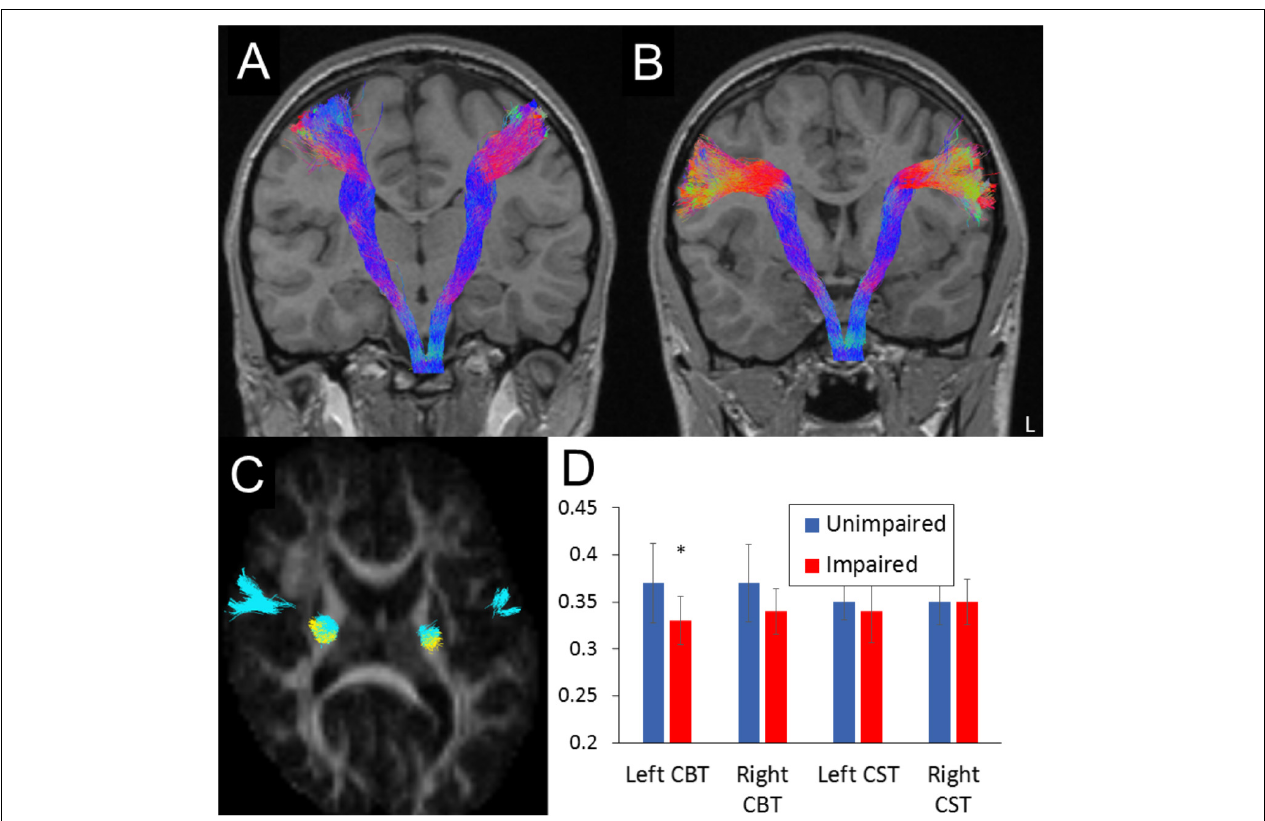
FIGURE 1 | Illustrative examples of (A) corticospinal and (B) dorsal corticobulbar tract tractography reconstruction in a participant. Tracts are projected on a T1-weighted MRI scan in coronal plane to allow view along the full tract length. Axial cross section (C) illustrates partial overlap of the two tracts (blue, corticobulbar or CBT; yellow, corticospinal or CST) at the level of the posterior limb of the internal capsule. L, left hemisphere. (D) Group differences in mean FA for each tract (error bars represent SDs; ∗ statistical difference p <